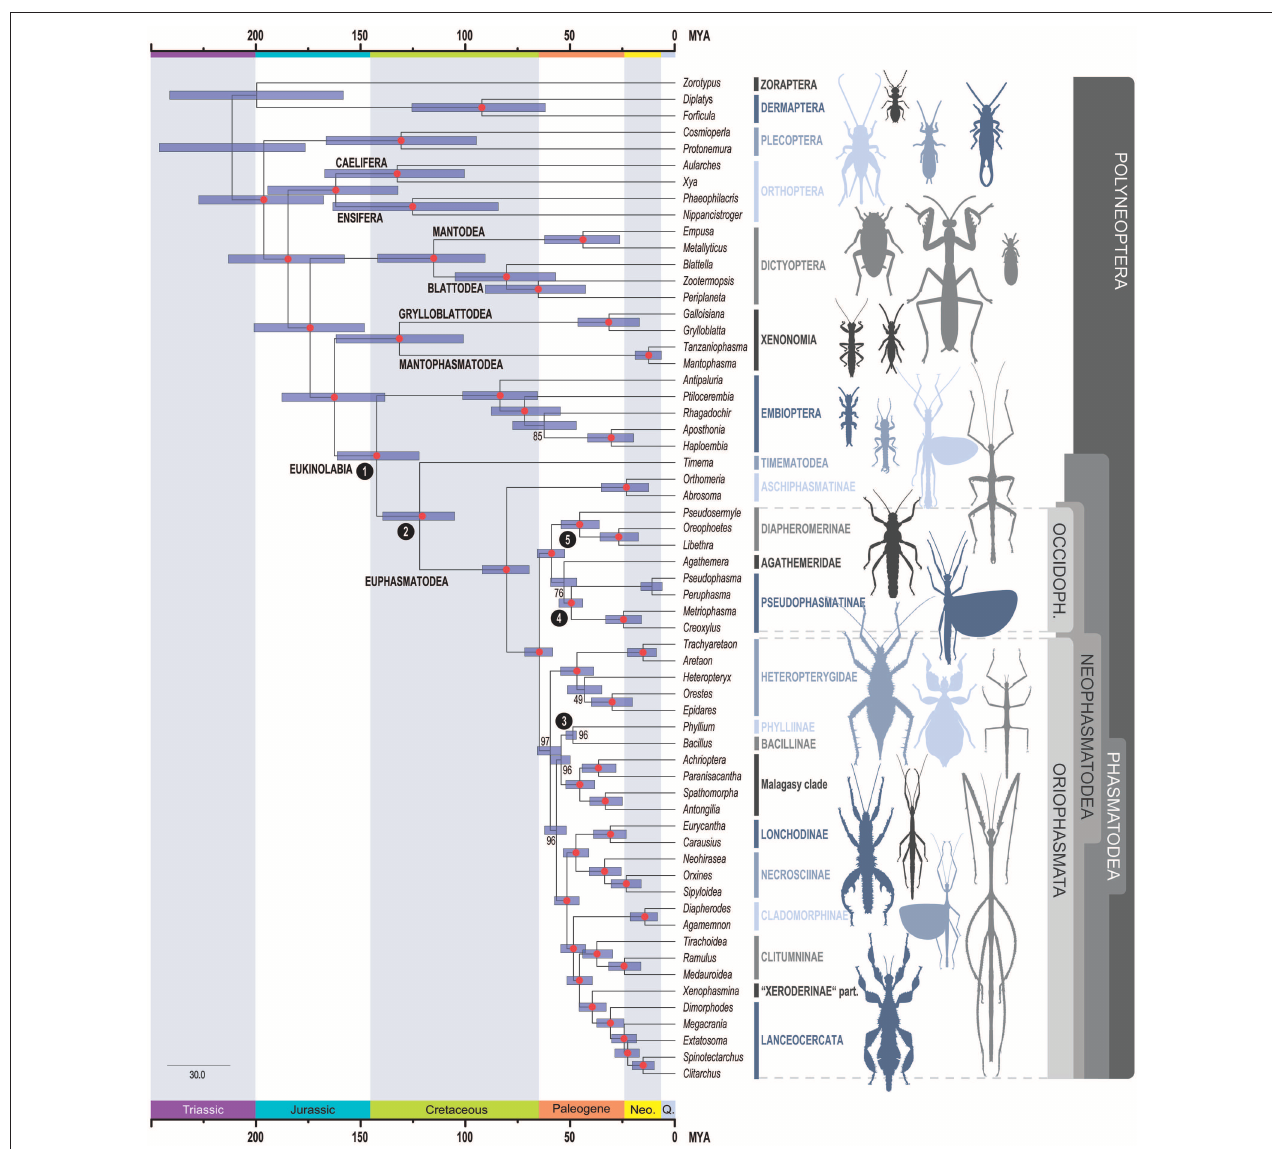
FIGURE 2 | Time-calibrated phylogeny of Phasmatodea. Inferred phylogenetic relationships based on dataset AA decisive (387,987 aa positions, 205 metapartitions). Colored circles represent bootstrap support derived from 100 BS. Node dates (posterior mean) were inferred using the dataset AA decisive reduced to sites containing > 95% data completeness, and five fossil calibrations. Error bars represent 95% confidence intervals. Fossils used for calibrations are indicated as numbers in black circles at nodes: 1: Nel and Delfosse (2011), 2: Wedmann et al. (2007), 3: Sellick (1994), 4, 5: Poinar (2011) (see also Table 1 ). OCCIDOPH., Occidophasmata; Neo., Neogene; Q.,